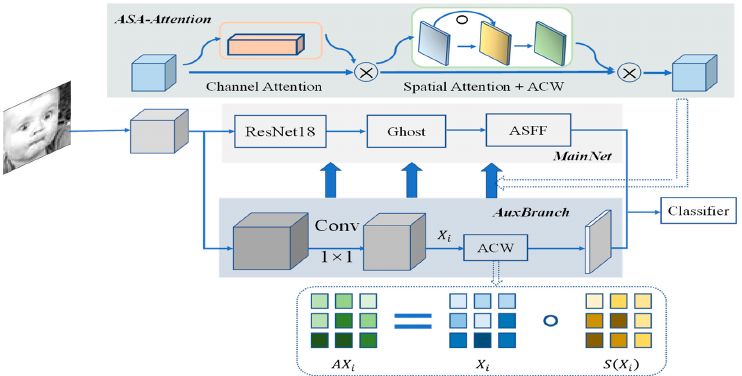
Figure 1. Overall network architecture of MAWNet